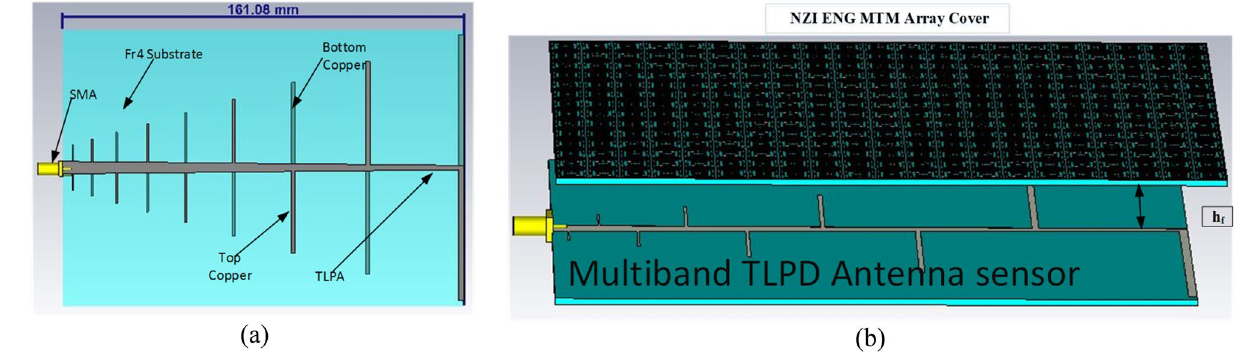
Figure 30. Designed TLPD Antenna with top and bottom copper ( a ) without NZI ENG metamaterial ( b ) with NZI metamaterial cover.